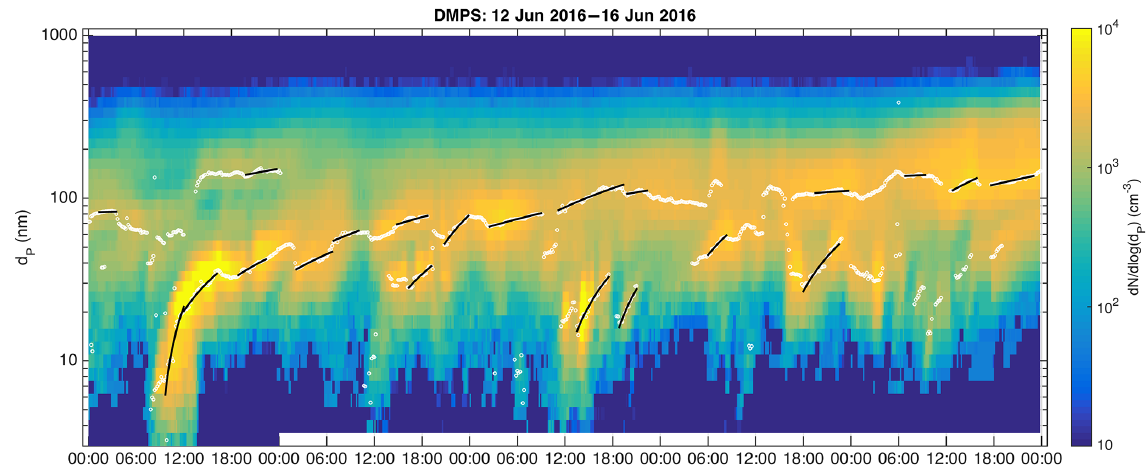
Figure 1. An example of the evolution of particle size distribution and the determined growth periods over five consecutive days in June 2016. White circles show the found peaks in particle size distribution and the black lines show the determined monotonic growth